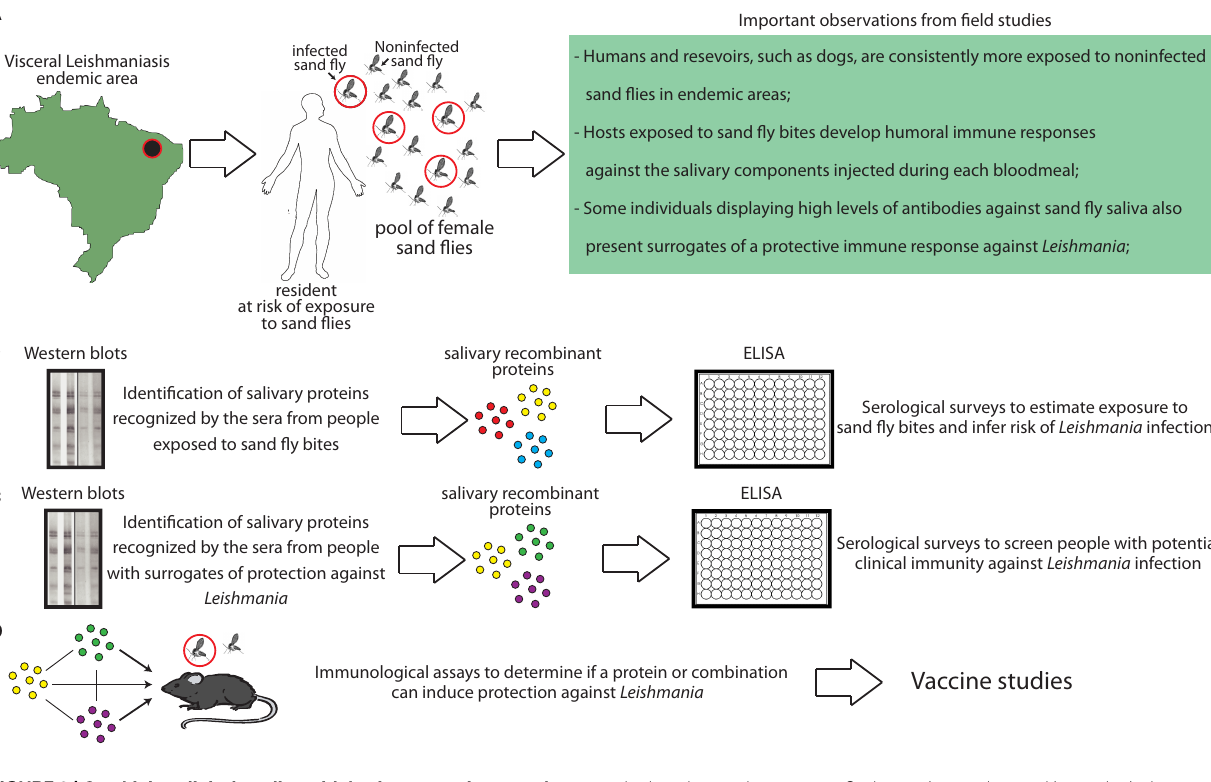
FIGURE 3 | Combining clinical studies with basic proteomic research to generate tools based on sand fly salivary proteins to aid the control of visceral leishmaniasis. (A) Epidemiological and entomological studies have provided critical knowledge to guide development of advanced research studies using sand fly saliva. Proteomic and transcriptome studies made possible to identify and isolate the salivary proteins that are immunogenic and elicit host antibody responses. In addition, we have recently shown an approach to produce large amounts of recombinant versions of these proteins in large-scale (Teixeira et al., 2010). (B) Some proteins are globally identified by